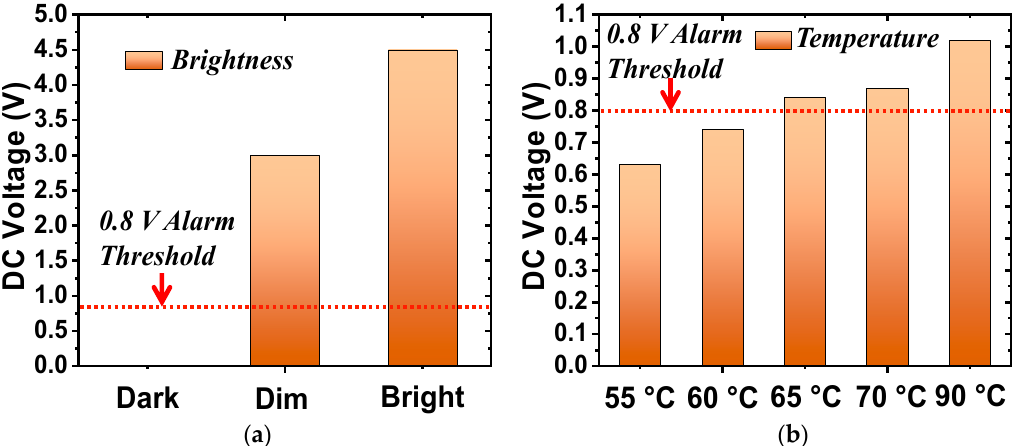
Figure 7. Measured output DC voltage of the sensor-augmented EAD rectennas. ( a ) Light sensor (photocell) system. ( b ) Temperature sensor (thermistor) system.